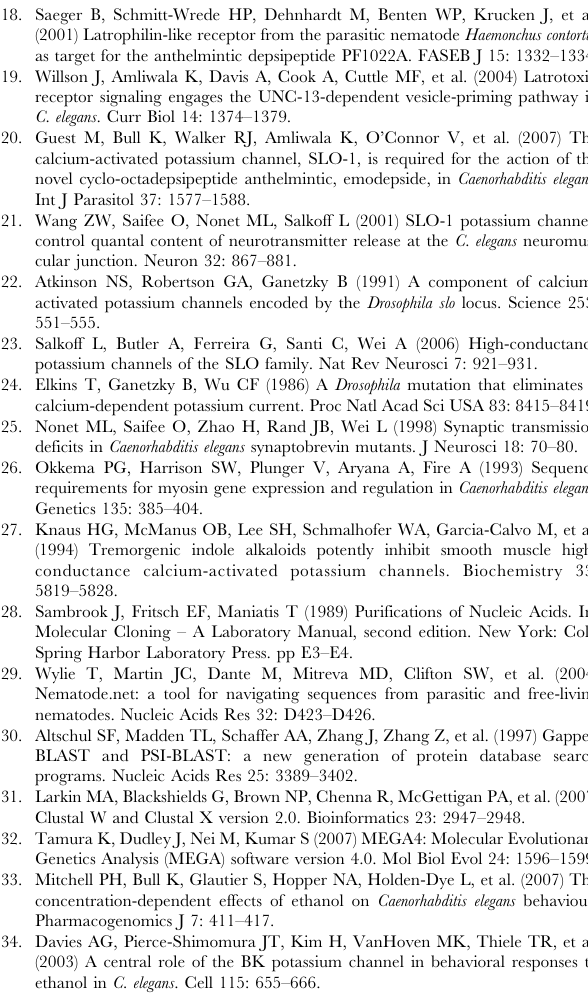
Table S2 Sequences of primers used for confirmation of transcription of the expression constructs. Each cDNA was tested with all primer pairs. * The primer pair Ce slo-1 RT mut Fw/Rv was used to confirm the success of RNA isolation and cDNA synthesis. The primers target the slo-1 transcript of C. elegans, which is also present in the slo-1 knockout strain js379, as the knockout is a translational one due to a premature stop codon. Therefore, this primer pair was used to control for successful cDNA synthesis. It spans the mutated region and can therefore also be used to amplify the region for sequencing. In contrast, the primer pair Ce slo-1 RT Fw III/Rv II for confirmation of the transcription of the C. elegans slo-1 expression construct does not